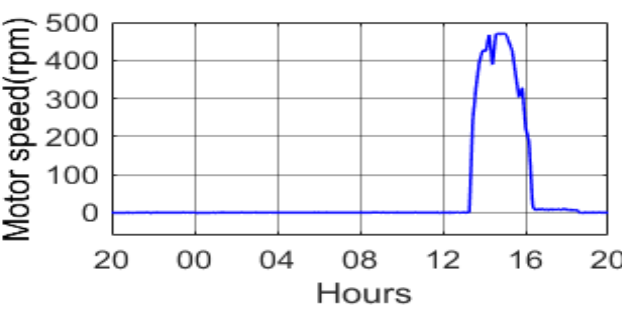
Figure 23. Motor speed of the ventilation system.